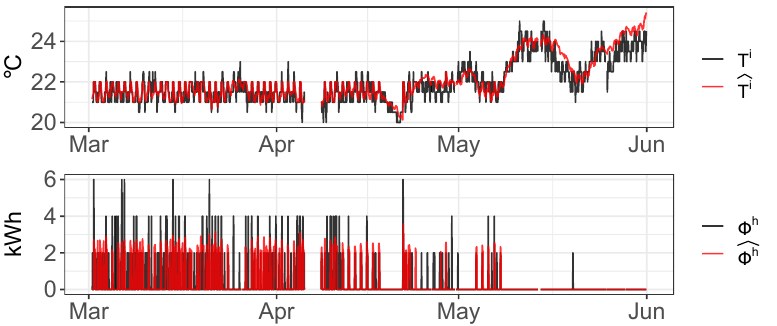
̂ Φ ̂ h forecasting from 1st March to 31st May using Algorithm A1 and T i and Figure 10. Accuracy of considering the real set point temperature ( T s , sim = T s ). The cumulative consumption over the period ̂ Φ h = 784 is: ∑ Φ h = 772 kWh ∑